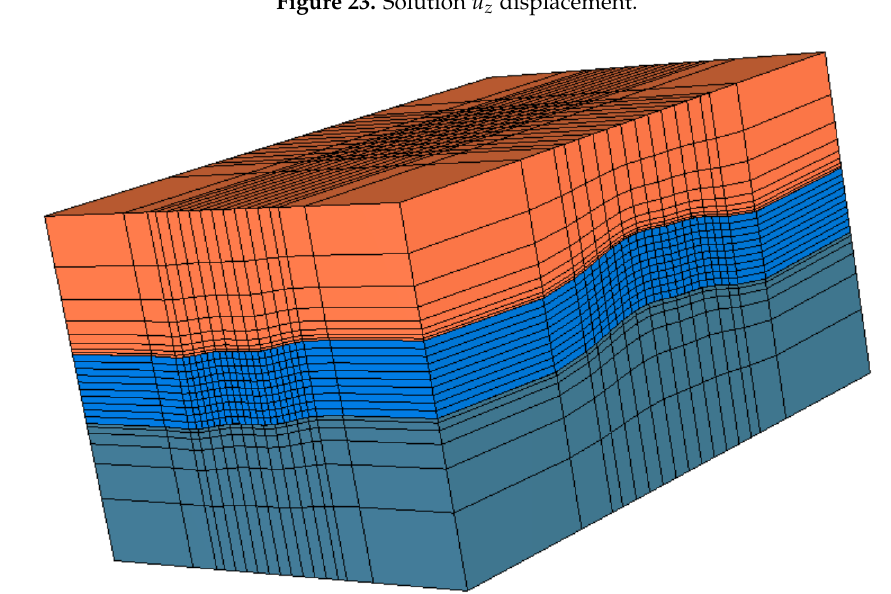
Figure 24. Meshes to use with